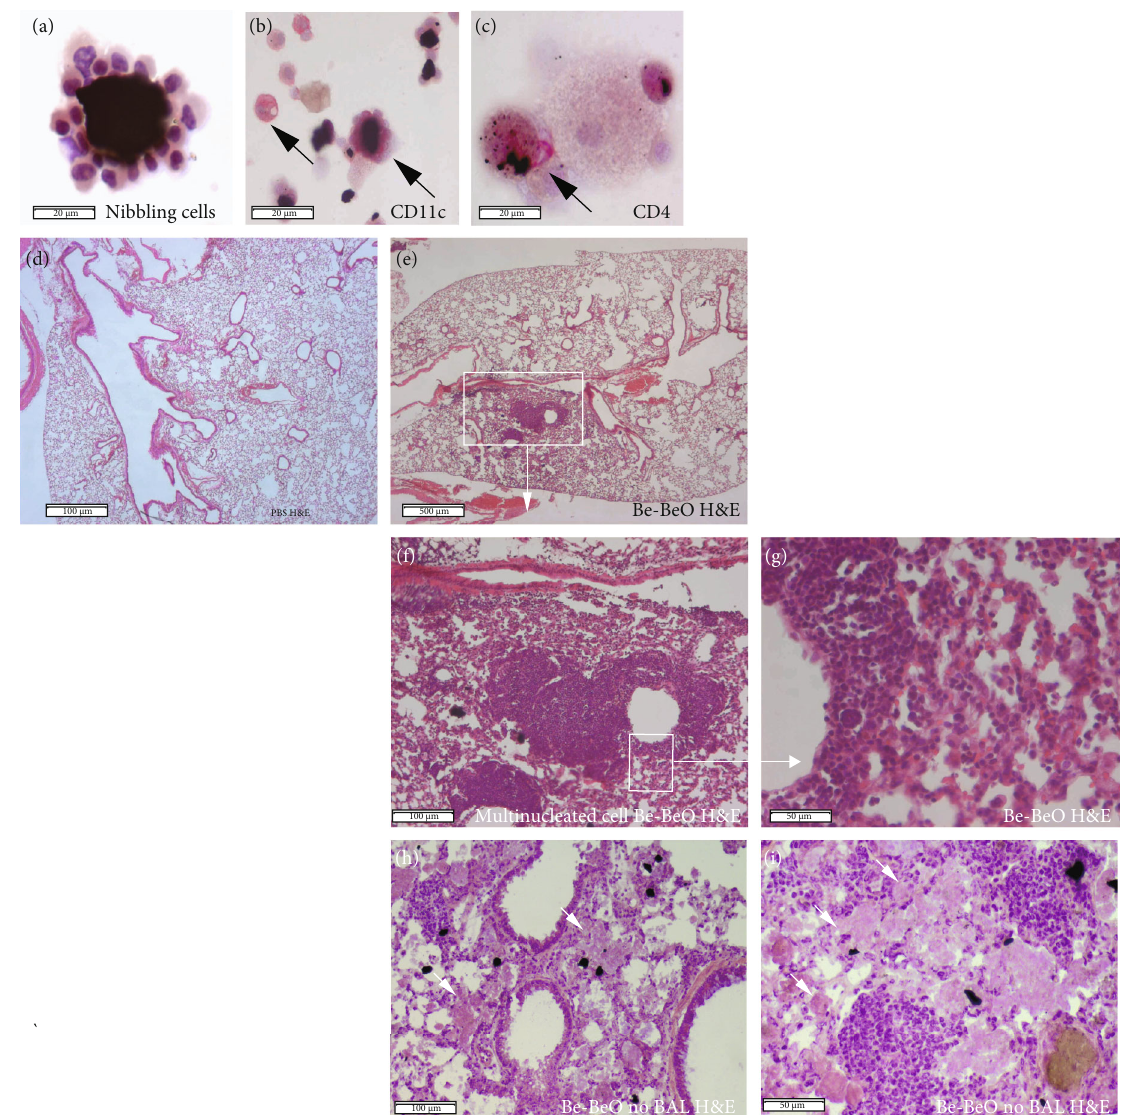
Figure 2: Identi fi cation of nibbling cells around beryllium particles and formation of focal dens in fi ltrates. (a – c) Cytospin analysis of BAL cells from CBD mice, analysed by hematoxylin and eosin (H&E) staining 8 weeks after initial exposure (a); immunohistochemical staining for CD11c + alveolar macrophages or DCs (red) (b); and for CD4 + T cells (red) (c). (d – i) Hematoxylin and eosin (H&E) analysis of lung sections. Staining of PBS-treated mice (d); Be-BeO-treated CBD mice following BAL collection (e – g) or without prior BAL collection, showing histiocytic and focal dense in fi ltrates. Black dots are Be particles, and brown gray dots are BeO particles. Arrows indicate the macrophage histiocytes, which were not present when BAL was performed. Data are representative for 3-5 mice analysed in each group. Data are expressed as the means ± SEM . Bars are 20 μ m (a, b, c), 50 μ m (f), 100 μ m (h), and 500 μ m (d,